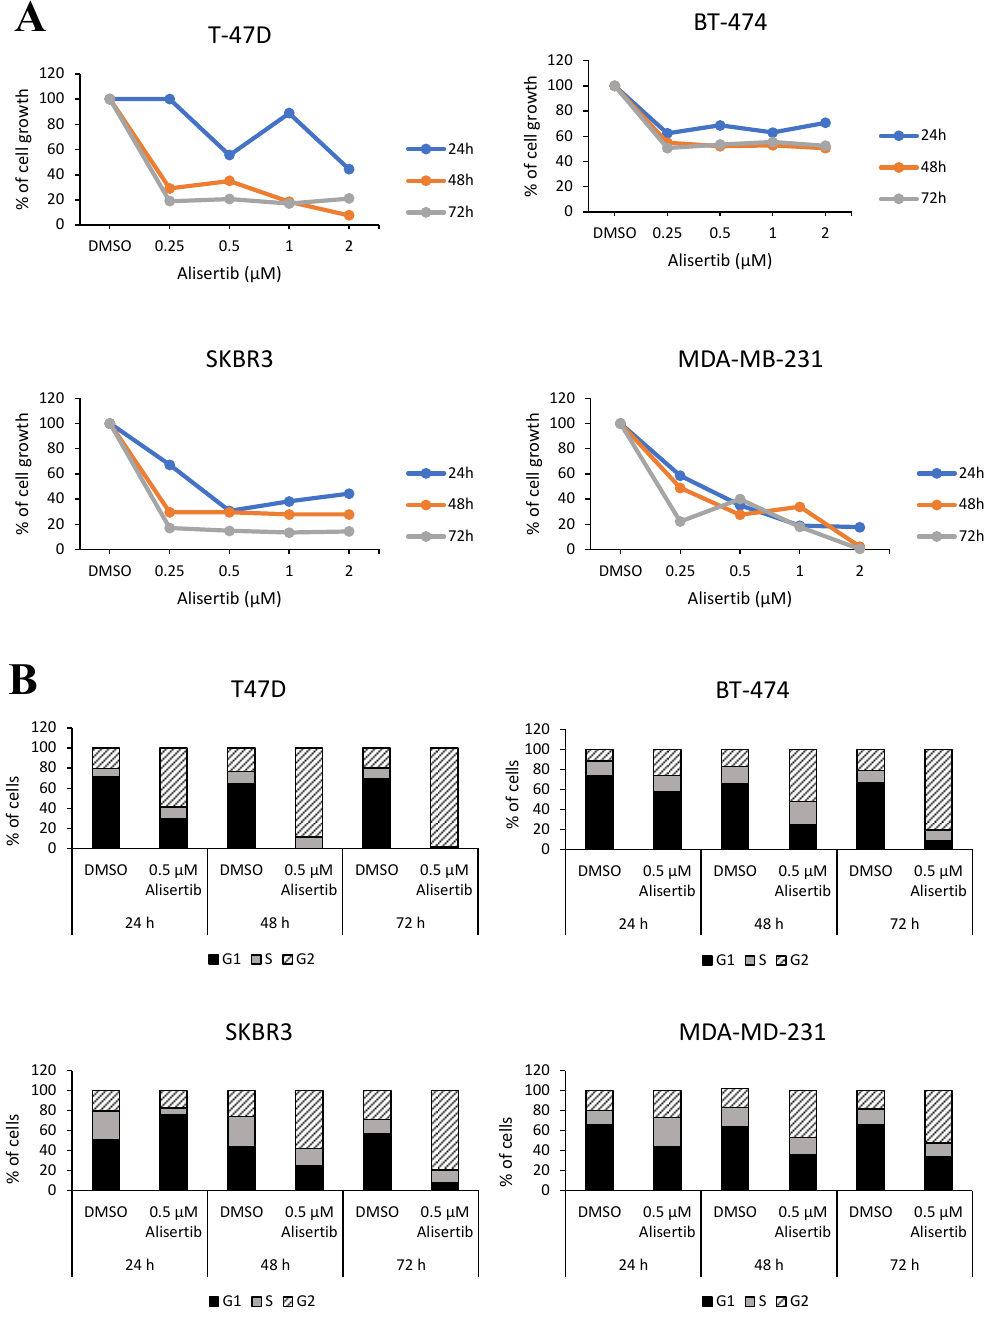
Figure 7. Effect of Alisertib treatment on BC cell lines. ( A ) Alisertib effects were assessed on cell growth: T-47D, BT-474, SKBR3, and MDA-MB-231 cell lines were treated with 0.25, 0.5, 1 and 2 µM of the drug for 24, 48, and 72 hours and DMSO treatment was used as a negative control. ( B ) Alisertib effects were assessed on cell cycle: T-47D, BT-474, SKBR3, and MDA-MB-231 cell lines were treated with 0.5 µM of the drug for 24, 48, and 72 h and DMSO treatment was used as a negative control.